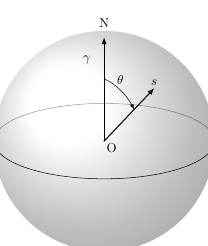
Figure 10. Domain of integration in (60), upon suitable rotation of the axis of the